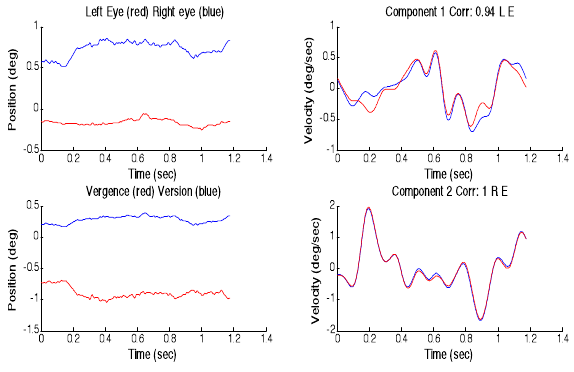
Figure 5 The late fusion sustaining portion of a vergence step response show as in Fig.